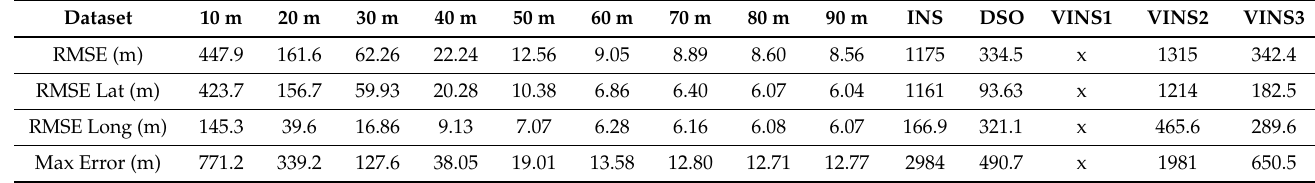
Table 2. Scenario 2 Localization Results (Trajectory Length: 4628 m) VINS1